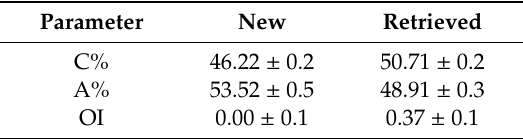
Table 1. Values of crystallinity, amorphous and oxidation index calculated according to the Equations (1)–(3) for unused and retrieved polymeric components (main value ± standard